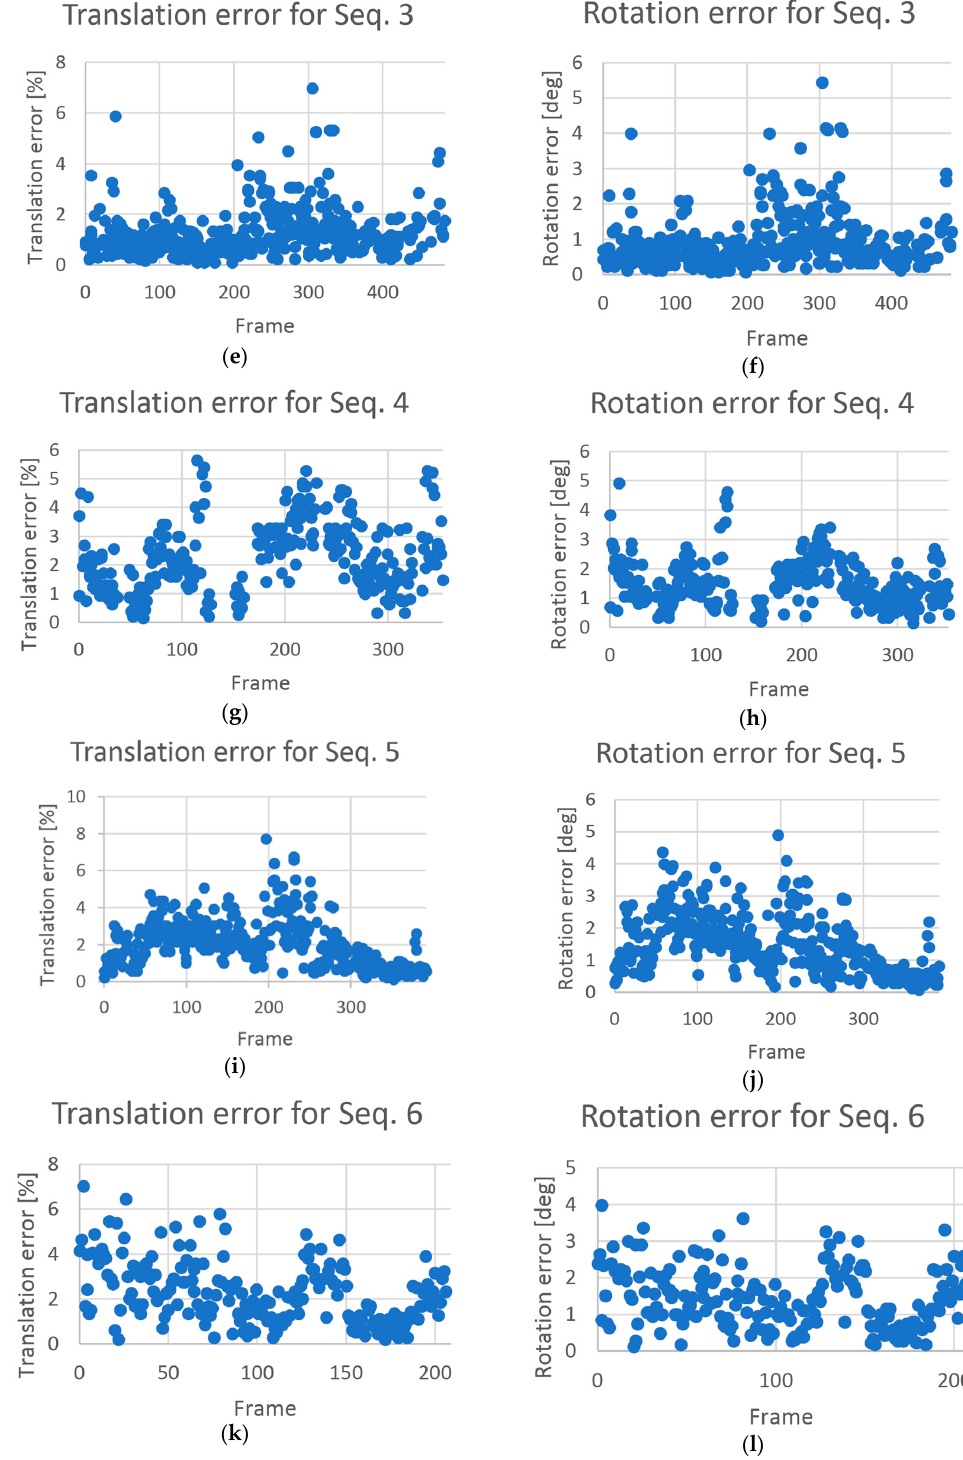
Figure 14. Error values in each test sequence. Left ( a ), ( c ), ( e) , ( g ), ( i ), and ( k ). Translation errors for sequences 1–6, respectively. Right ( b ), ( d ), ( f ), ( h ), ( j ), and ( l ). Rotation errors for sequences 1–6, respectively.